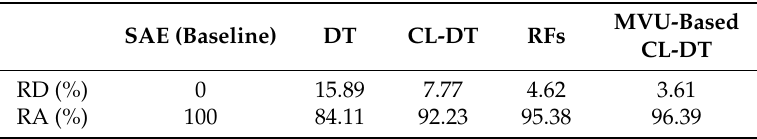
Table 6. The RD of classification results and RA in the 3rd test